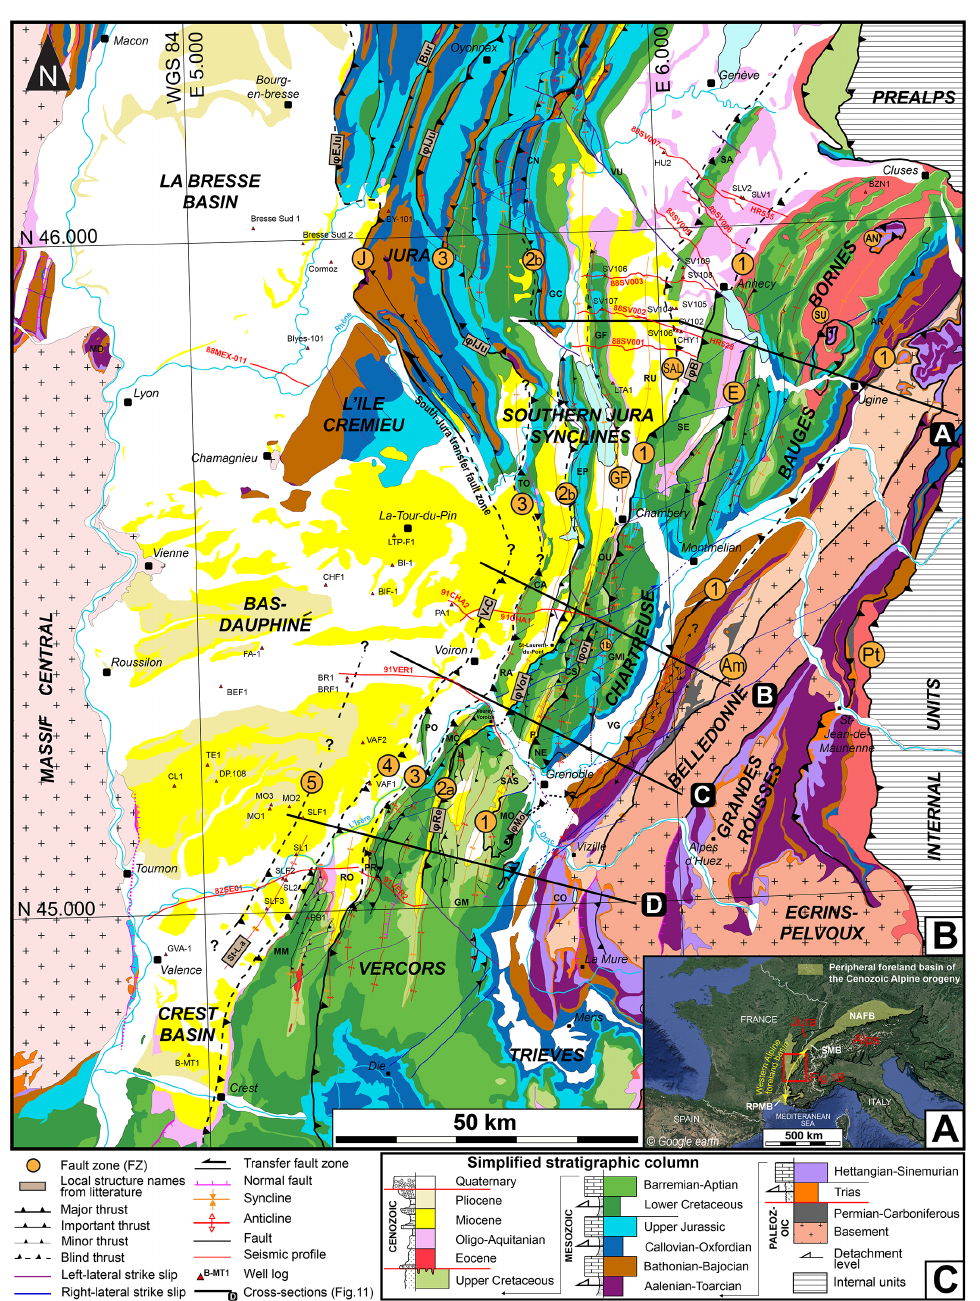
Figure 1. (A) Location of the western Alpine foreland basin and the study area. NAFB: North Alpine Foreland Basin. SMB: Swiss molasse basin. RPMB: Rhodano–Provencal molasse basin. (B) Structural map of the subalpine massifs, the southern Jura, and adjacent basins (Bas- Dauphiné, Crest, La Bresse). Names of the main faults are indicated within orange circles: 1 to 5 are fault zones (FZs) defined in this study. PT: Penninic thrust; Am: internal Belledonne thrust; E: Entrevernes thrust; SAL: Salève thrust; J: Jura thrust; SU: Sulens klippe; AN: Annes klippe. Local fault names from the literature are as follows. ϕ B: Bauges thrust; ϕ EJu: external Jura thrust; ϕ IJu: internal Jura thrust; ϕ Mo: Moucherotte thrust; ϕ or: oriental Chartreuse thrust; ϕ vor: Voreppe thrust; ϕ Re: Rencurel thrust; Bur: Buron thrust; St-L.a: Saint Lattier anticline; V-C: Voiron–Chirens fault. Local ranges and structures names are as follows. AR: Aravis; CA: Chailles; CN: Crêt du Nu; CO: Conest; EP: Epine; GC: Grand Colombier; GM: Grande Moucherolle; GMI: Grand Manti; GF: Gros Foug anticline; MC: Montaud col; MD: Monts-d’or; MM: Monts-du-Matin; MO: Moucherotte; NE: Néron; P: Proveyzieux anticline; PO: Poliénas; PR: Pont-en-Royans anticline; OU: Outherans; RA: Ratz; RO: Royans; RU: Rumilly syncline; SA: Salève; SAS: Sassenage; SE: Semnoz; TO: Tournier; VG: Grésivaudan valley; VU: Vuache. Seismic profiles appear as red lines and wells as red triangles. (C) Simplified synthetic stratigraphic column of the area stressing the main unconformities (red lines) and potential detachment levels (arrows). Same colors as for Figs. 3, 7, 8, 9, 10, 11, 14, and S1. https://doi.org/10.5194/se-12-2735-2021 Solid Earth, 12, 2735–2771,